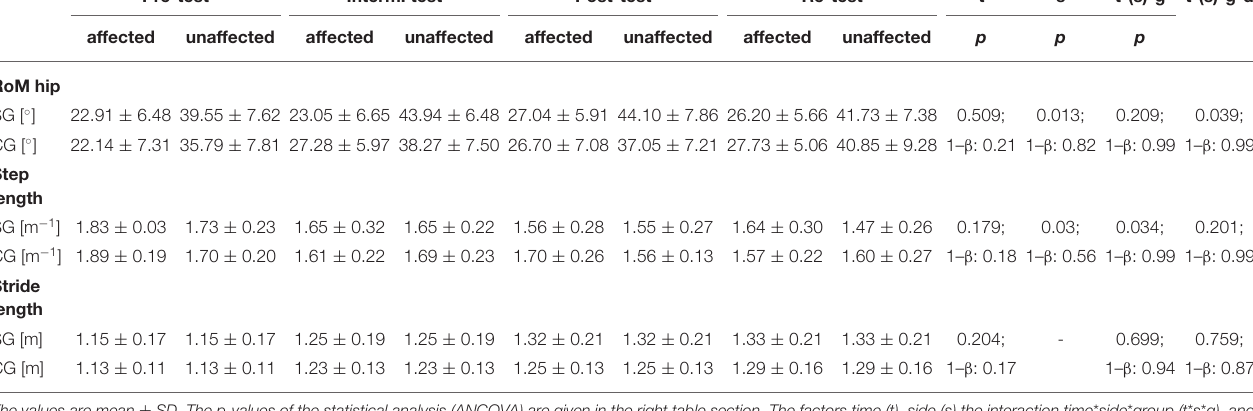
TABLE 3 | Spatial gait parameters at the four test dates for the affected and unaffected leg of the sonification group (SG) and the control group (CG).